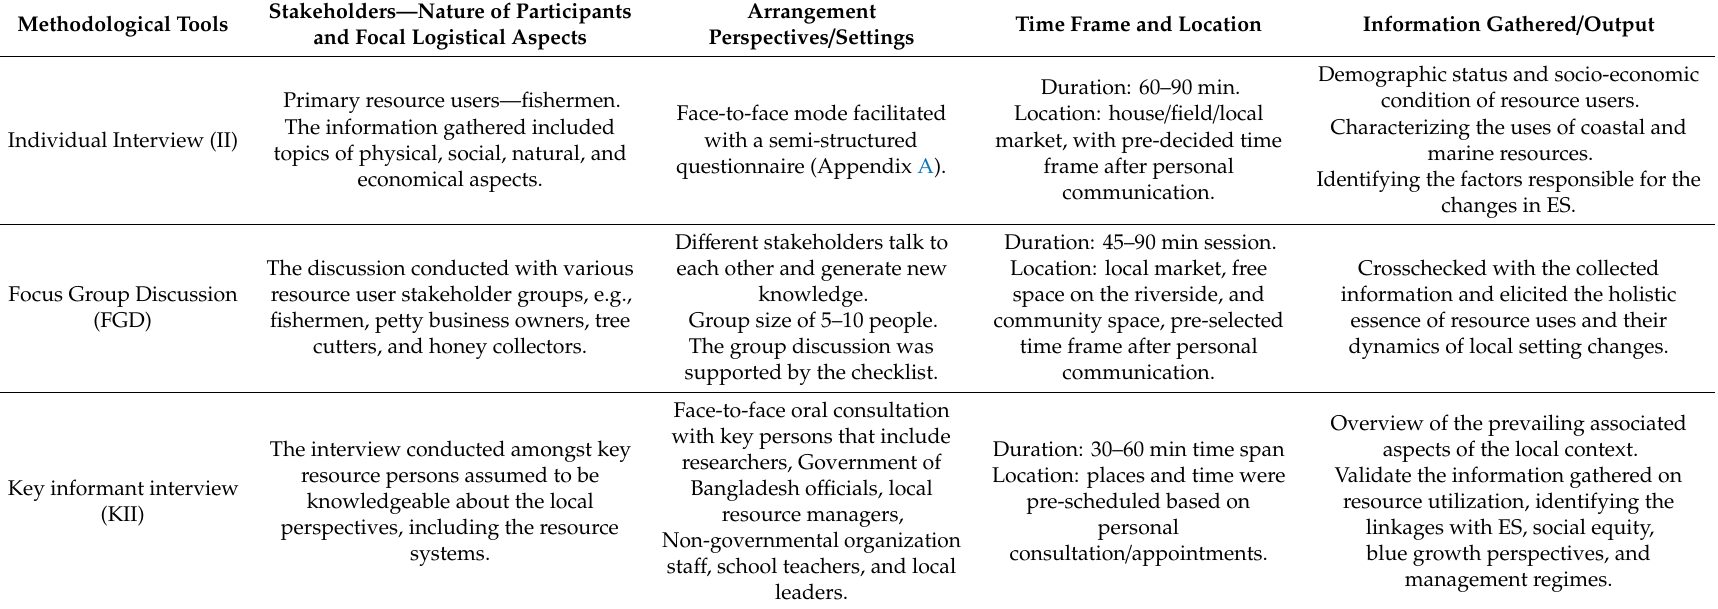
Table 3. Methodological tools within the Participatory Rural Appraisal (PRA) framework, nature of participants and focal logistical aspects, arrangement perspectives, and gathered information employed in the